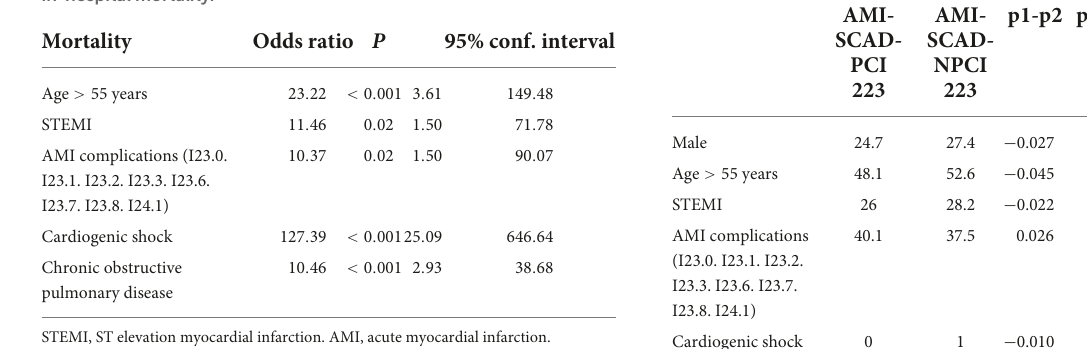
TABLE 3 Baseline characteristics of the matched cohorts.